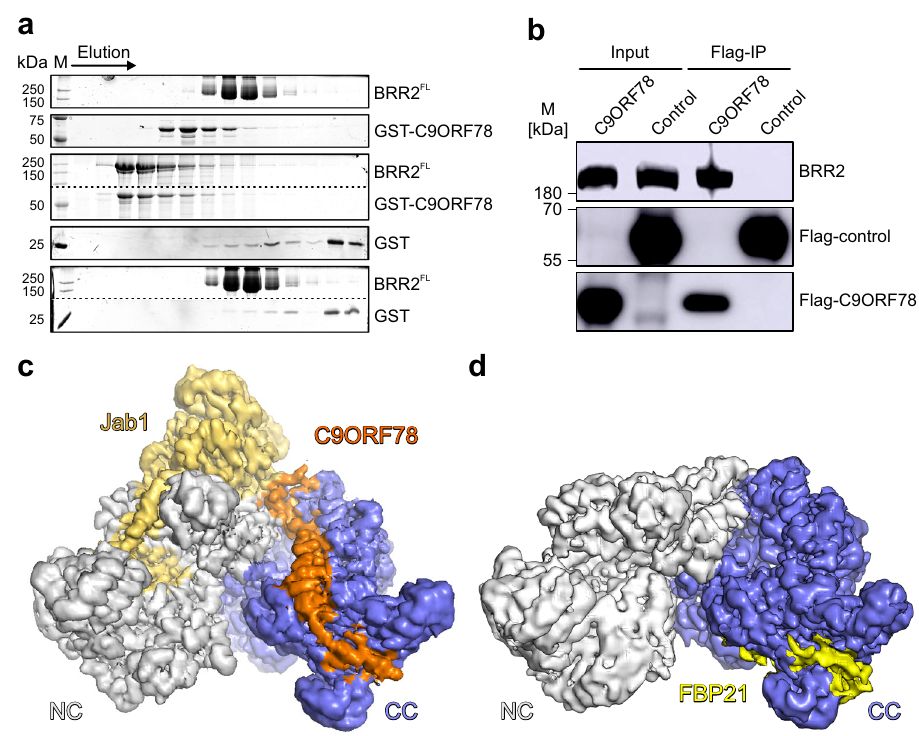
Fig. 1 C9ORF78 stably interacts with BRR2. a SDS – PAGE gels showing elution fractions from analytical SEC, monitoring interaction of GST-C9ORF78 with BRR2 FL . Elution direction is indicated by an arrow. The same elution fractions from runs under identical conditions are shown. Protein bands are identi fi ed on the right. M, molecular mass marker. In the third and fi fth panel, upper and lower regions of the same gels were spliced together. Dotted lines, splice positions. Independent experiments were conducted at least twice with similar results. b C9ORF78 interacts with BRR2 in HEK293T cells. Flag-IP with HEK293T nuclear extract followed by Western blot and antibody staining against BRR2 (top) or Flag-tag (middle and bottom). Flag-CLK1 protein was taken as negative control (Flag-control). Protein bands are identi fi ed on the right. M, molecular mass marker. Independent experiments were conducted twice with similar results. Source data for a and b are provided as a Source Data fi le. c CryoEM map of a BRR2 HR -PRPF8 Jab1 -C9ORF78 complex at 2.76 Å resolution, contoured at 6 root-mean-square-deviation (RMSD). Color coding in this and the following fi gures: BRR2 NC, gray; BRR2 CC), slate blue; PRPF8 Jab1 , gold; C9ORF78, orange. d CryoEM map of a BRR2 HR -FBP21 200-376 complex at 3.3 Å resolution, contoured at 6 RMSD. Color coding in this and the following fi gures: FBP21 200-376 ,